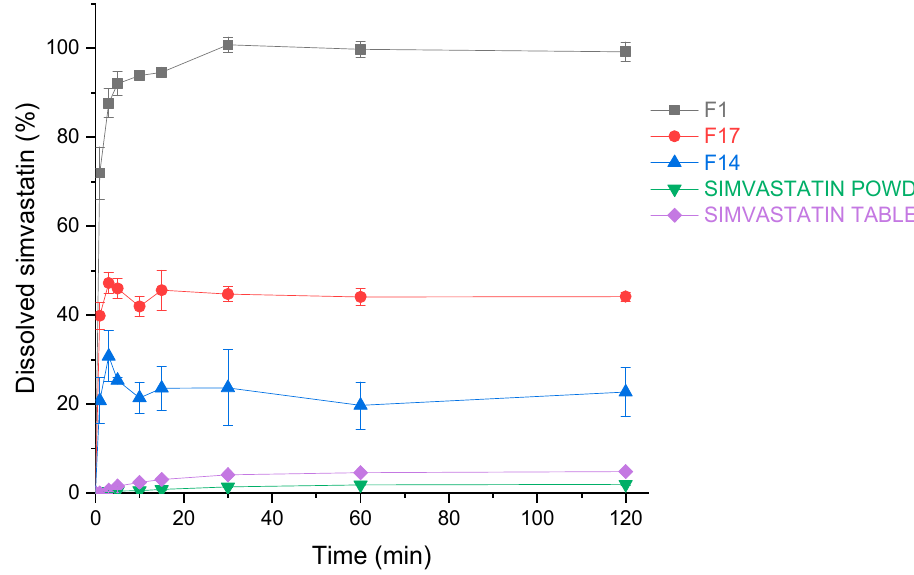
Figure 14. The dissolution profiles of simvastatin for simvastatin powder, simvastatin tablets and experiments F1, F14 and F17. Each data point is expressed as the mean percentage ± SD of three determinations.